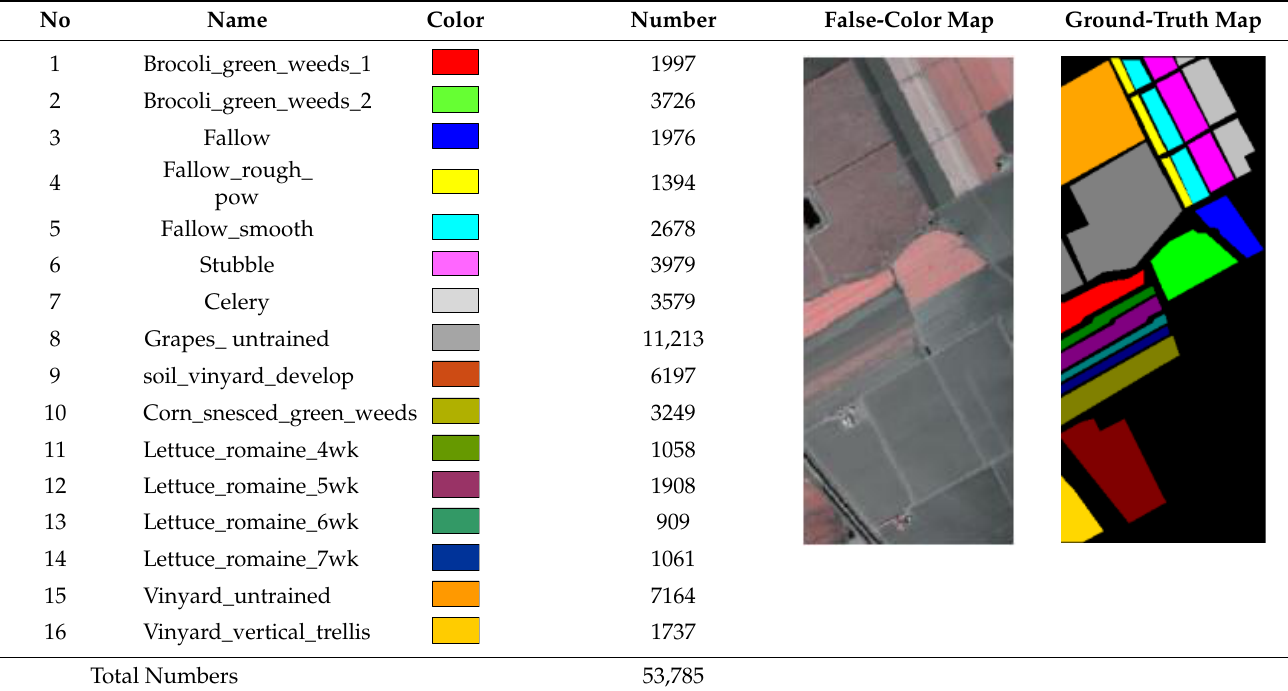
Table 1. Salinas Dataset Labeled Sample Counts.